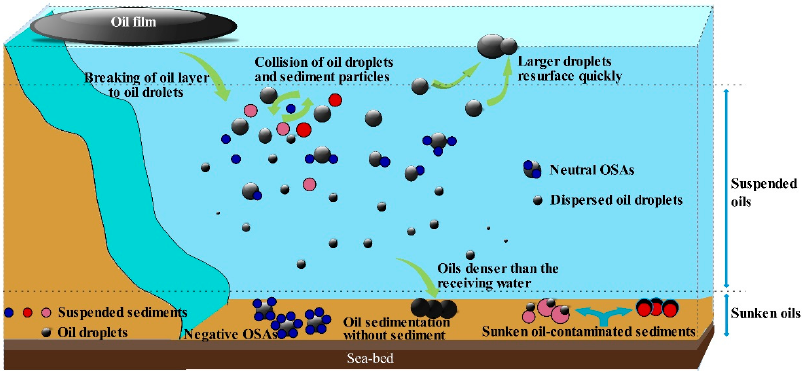
Figure 1. Formation and fate of sunken and suspended oils (SSO) in the marine environment.